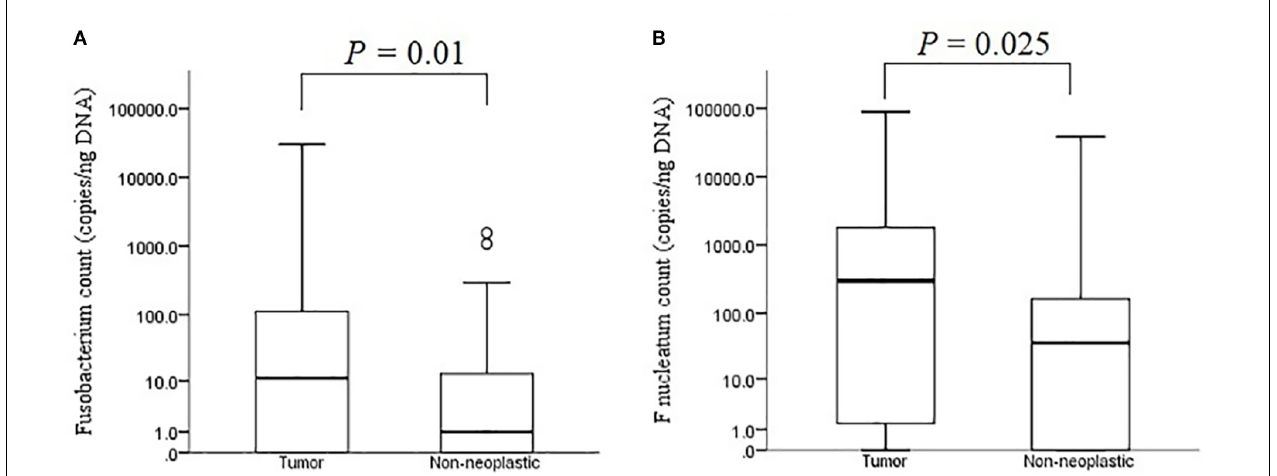
FIGURE 7 | Absolute bacterial counts of Fusobacterium (A) and F. nucleatum (B) in the tumour and non-neoplastic